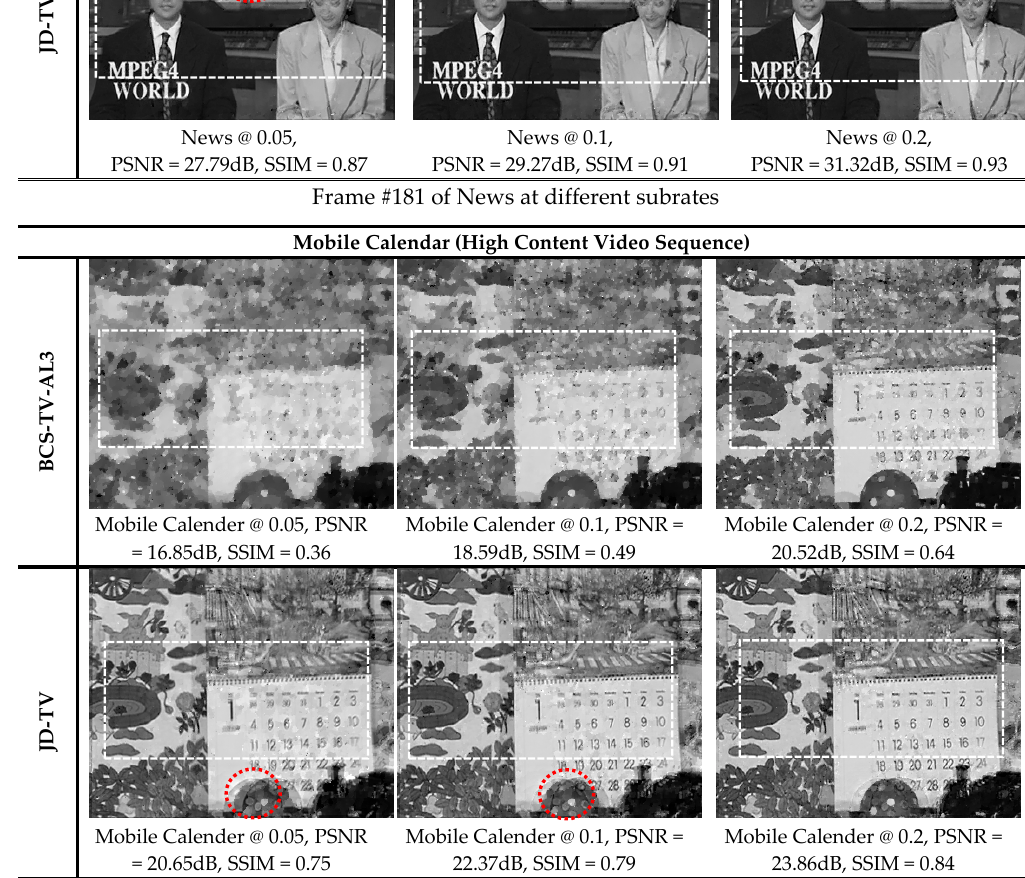
Figure 6. Visual quality analysis of different video sequences at multiple subrates using independent BCS-TV-AL3 and the proposed JD-TV.